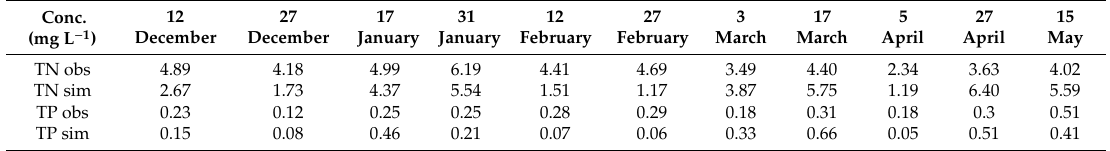
Table 3. Observed and simulated TN and TP concentration at the Monastir River section.